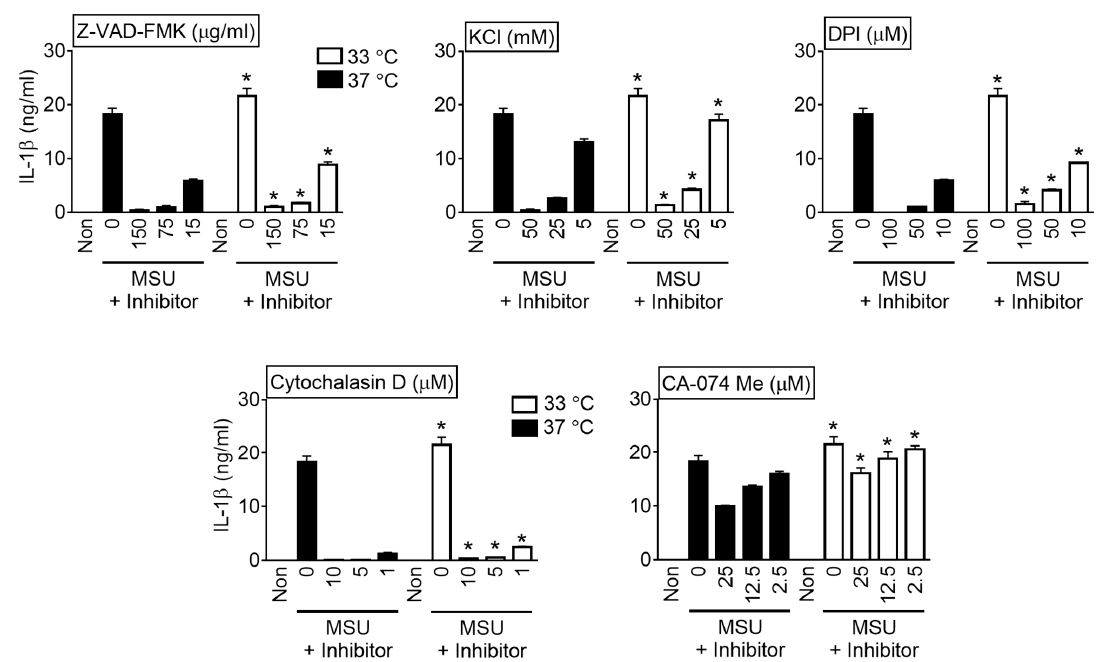
Figure 4. Effect of inhibitors on MSU crystal-mediating inflammasome activation at different temperature. LPS-primed BMDMs activated NLRP3 inflammasome by MSU crystals at 33 or 37 °C in the presence of inhibitors (Z-VAD-FMK, KCl, DPI, cytochalasin D, or CA-074 Me). IL-1 β secretion was analyzed by ELISA. The bar graphs represent the mean ± standard deviation (SD) of at least two independent experiments. * p < 0.05 vs. 37 °C.